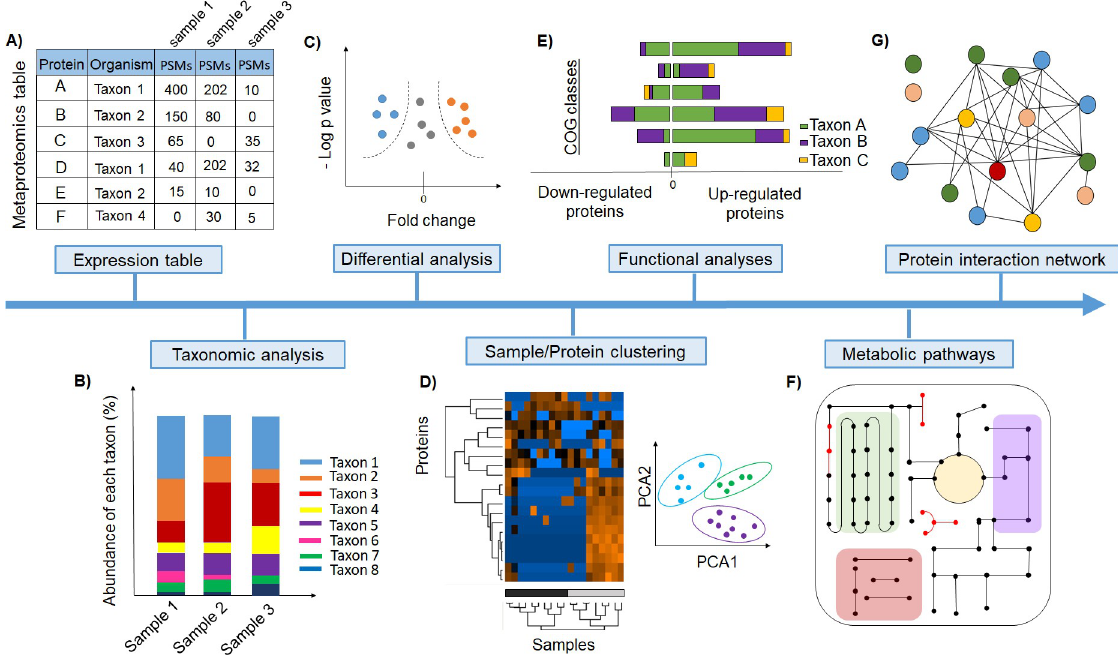
Fig 2. Examples of different analysis approaches to extract and help the interpretation of biological information from metaproteome datasets. (A) Table containing all proteins identified per taxon and associated PSMs. (B) Microbiome composition in terms of biomass contributions can be provided by the summed relative protein abundance of each taxon. (C) Volcano plots display abundance differences and thresholds derived from statistical tests corrected for multiple hypothesis testing and allow for the identification of differentially abundant proteins between treatments/conditions. (D) Multivariate analyses, visualized by PCA plots and hierarchical clustering, help to classify samples according to protein abundance differences. (E) COG represent functional protein groups across different microbes. (F) Pathway reconstruction supported by pathway databases. (G) Analyses of protein–protein interaction networks by mapping protein functional categories. These types of tests and visualizations are available through R packages [30] or the free GUI-based software Perseus [31] customized for proteomic data analysis. COG, Clusters of Ortholog Groups; PCA, principal component analysis; PSM, peptide- spectrum match.